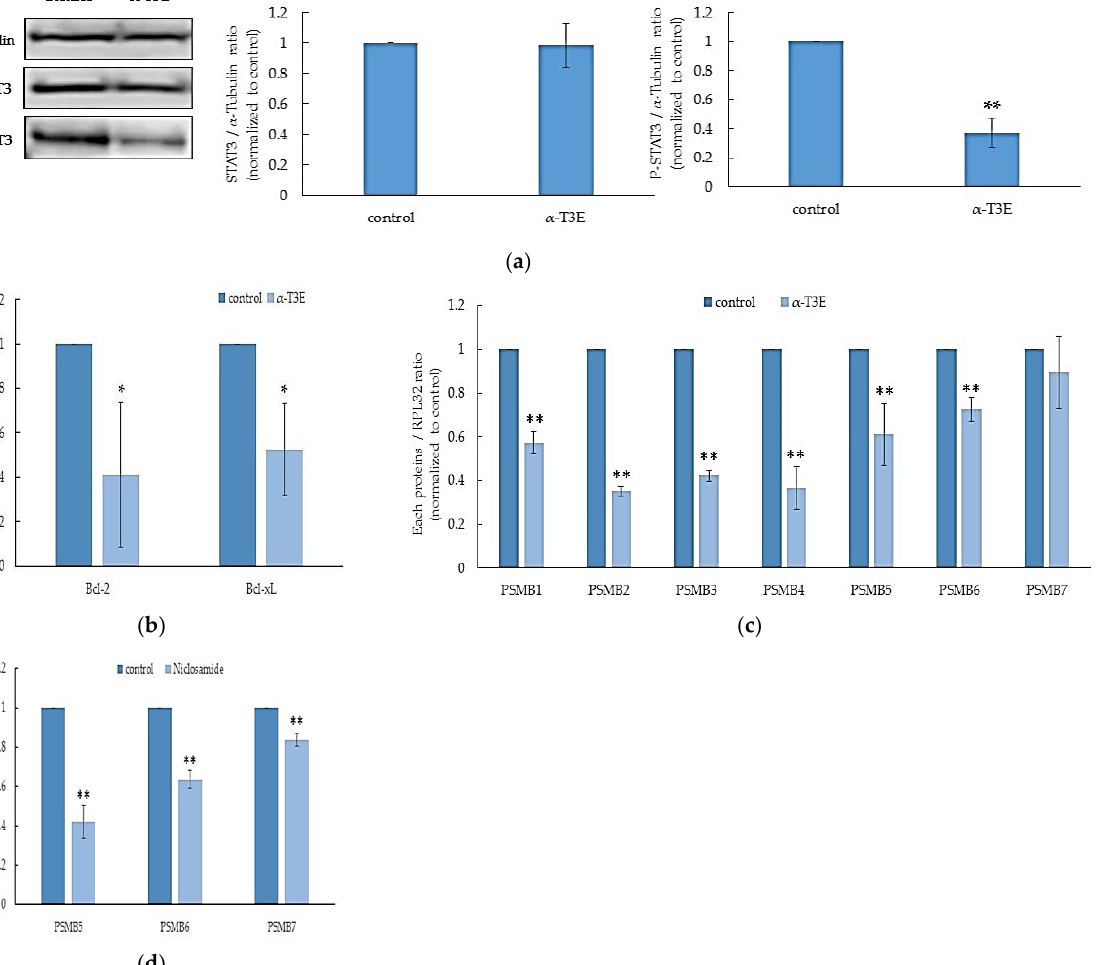
Figure 3. Contribution of α -T3E-dependent STAT3 inactivation to the inhibition of proteasome subunits in H2452 cells. ( a ) Cells were treated with α -T3E (20 µ M) for 24 h, and STAT3 and phos- phorylated P-STAT3 protein levels were assessed by immunoblotting. The α -Tubulin protein levels served as the loading control. A densitometric analysis was performed as described in Section 4.7. The data are means ± SD, n = 3. ** p < 0.01 vs. the control. ( b ) Cells were treated with α -T3E (20 µ M) for 24 h, and the mRNA levels of BCL-2 and BCL-XL were assessed by real-time quantitative PCR as described in Section 4.6. The data are means ± SD, n = 3. * p < 0.05 vs. the control. ( c ) Cells were treated with α -T3E (20 µ M) for 24 h, and the mRNA levels of proteasome subunits were assessed by real-time quantitative PCR. The data are means ± SD, n = 3. ** p < 0.01 vs. the control. ( d ) Cells were treated with niclosamide (10 µ M) for 24 h, and the mRNA levels of proteasome subunits were assessed by real-time quantitative PCR. The data are means ± SD, n = 3. ** p < 0.01 vs. the